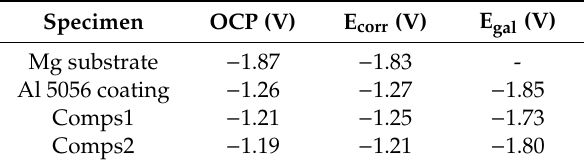
Figure 6. Effect of stirring on galvanic corrosion of Comps2 / Mg couple.